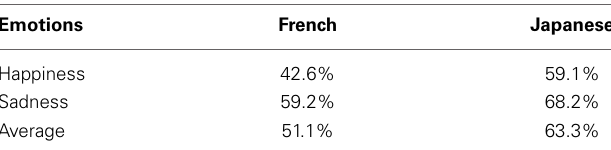
Table 2 | Emotion